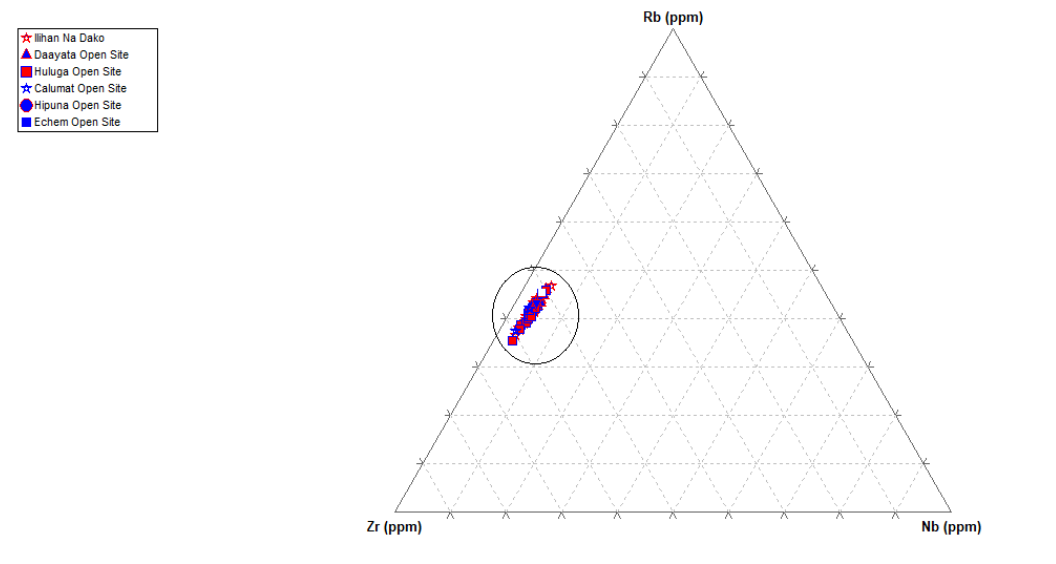
Figure 2. Ternary diagram showing clusters of Mindanao